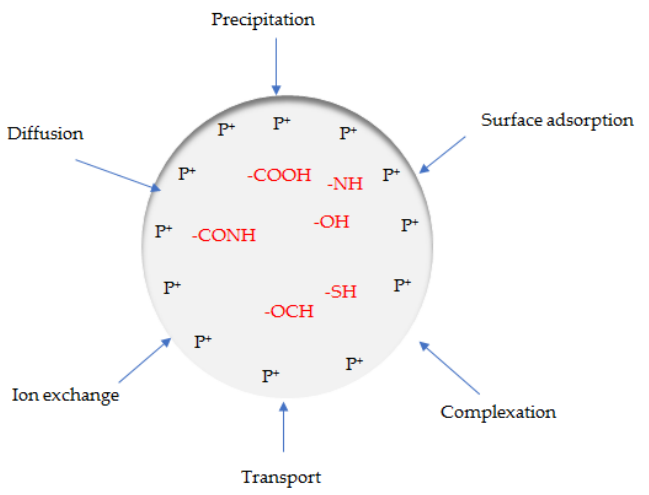
Figure 1. Possible mechanism routes for biosorbents (P + = pollutant and COOH, NH, OH, COH, SH, or OCH = functional groups).